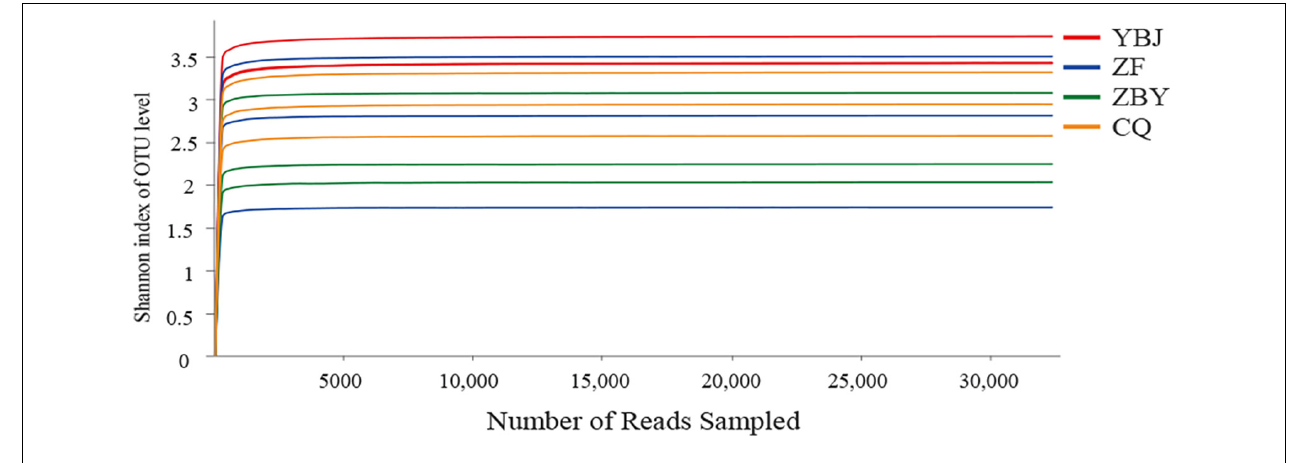
FIGURE 1 | Shannon dilution curve and diversity index difference.